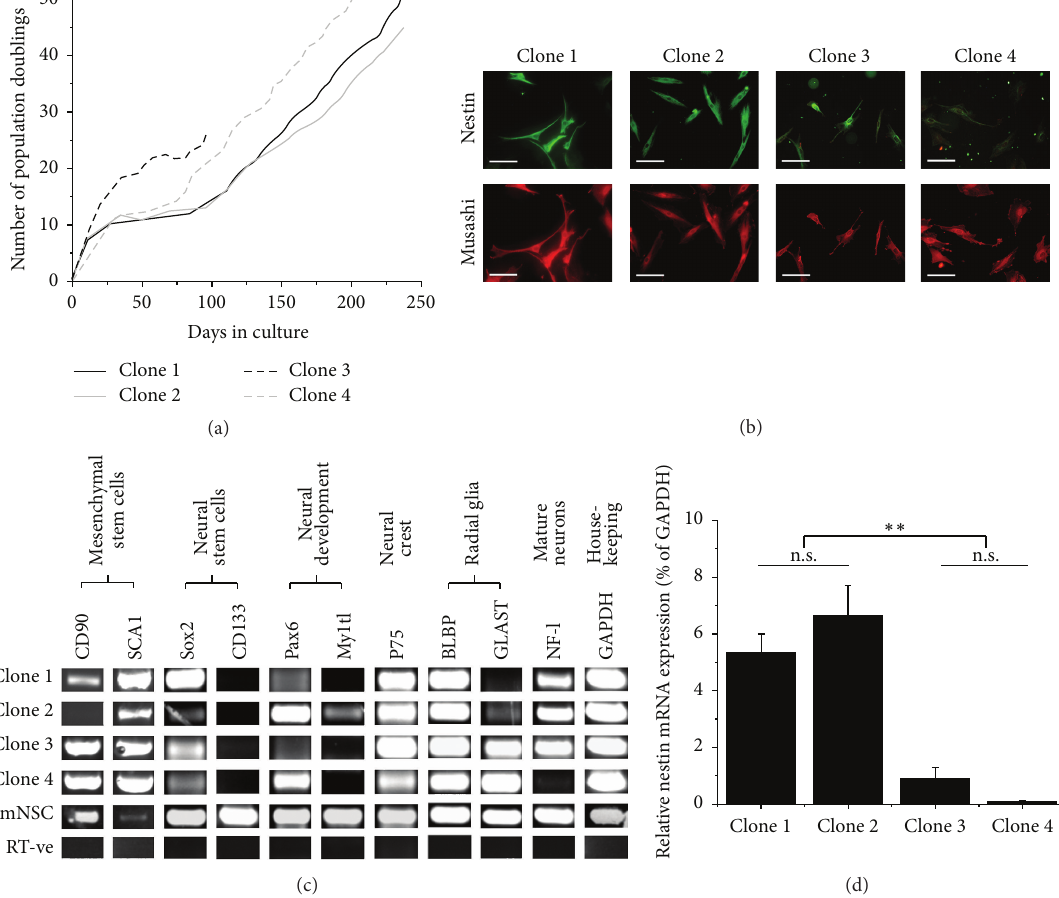
Figure 1: In vitro expansion and heterogeneity in the expression of developmental markers by clonal mDPSC cultures. (a) Single cell- derived clones, each expanded from a separate pulpal extraction, proliferated steadily for up to 240 days of culture reaching 50+ population doublings ( 𝑛 = 4 clones). Traces represent continuous culture growth from day of primary isolation, and cryopreserved cells continued to proliferate beyond the population doublings indicated. (b) Double immunostaining of clonal cultures for neural progenitor markers nestin and musashi. (c) RNA extracted from each clone between 20 and 40 population doublings was used in RT-PCR to identify clonal differences in the expression of RNA transcripts for CD90, stem cell antigen 1 (SCA1), glutamate aspartate transporter (GLAST), Sox2, Pax6, myelin transcription factor 1-like (Myt1l), P75, musashi, neurofilament light chain (NF-l), and CD133. (d) qPCR analysis of nestin mRNA expression by four mDPSC clones. Clones 1 and 2 were each individually found to express significantly higher levels of nestin than both clones 3 and 4. DPSC cultures were subsequently divided into strongly nestin-positive clones (clone 1 and clone 2) and weakly nestin-positive clones (clone 3 and clone 4). Nestin expression was calculated as a relative percentage of GAPDH ± SEM using the 2 −ΔΔ CT method ( 𝑛 = 3 , RNA samples extracted from three separate passages per clone between 16 and 40 population doublings). One-way ANOVA with Tukey-Kramer posttest: n.s. = not significant, ∗∗ 𝑝 < 0.01 . Scale bars = 100 𝜇